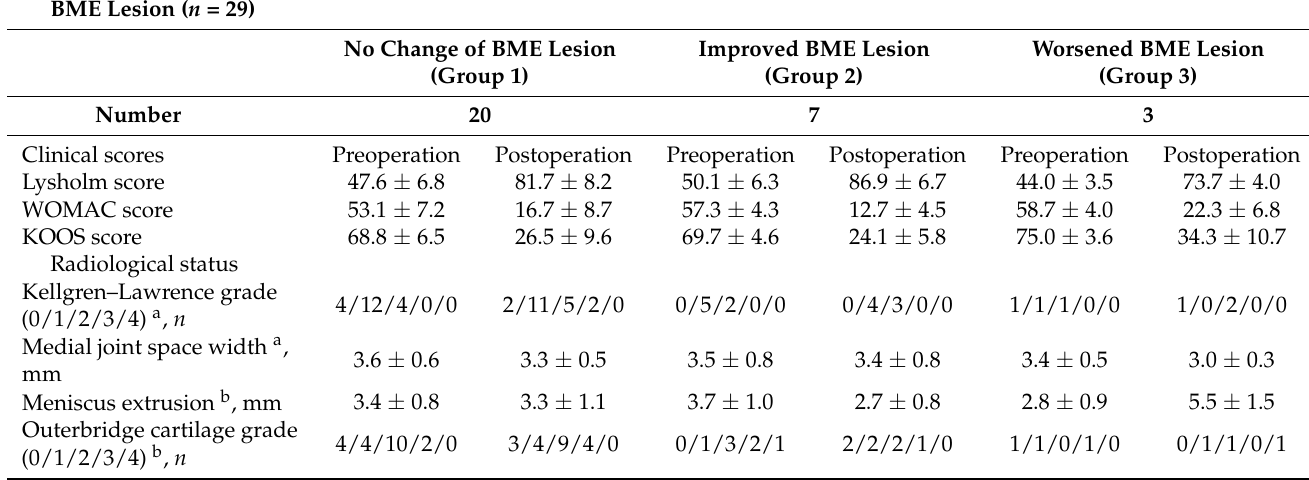
Table 3. Pre-operative and Post-operative Clinical and Radiological Outcomes in Each